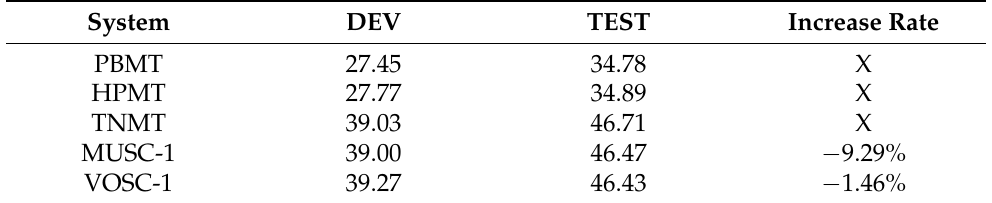
Table 5. Results on heterogeneous systems with different performance for Uyghur–Chinese